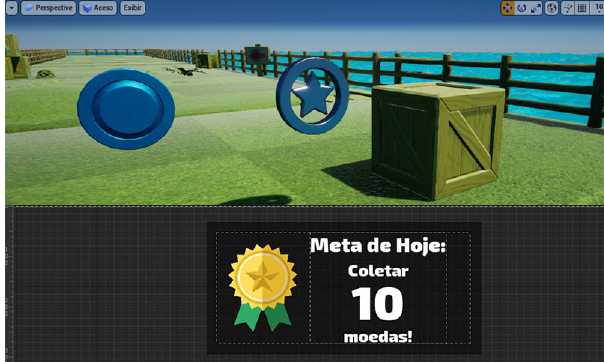
Figure 9. Obstacles and collectable objects (in